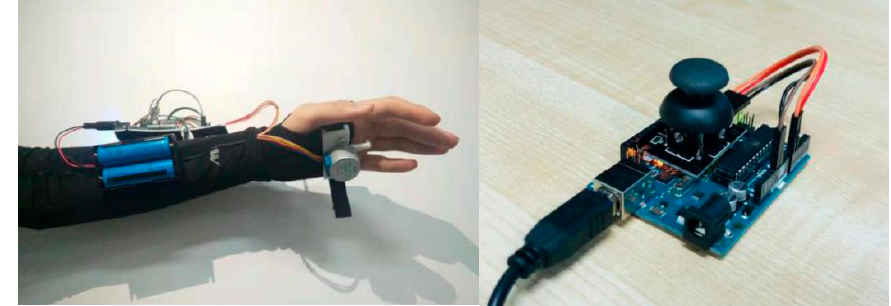
Figure 13. ( Left ) Prototype of haptic glove. ( Right ) Joystick for test purpose.